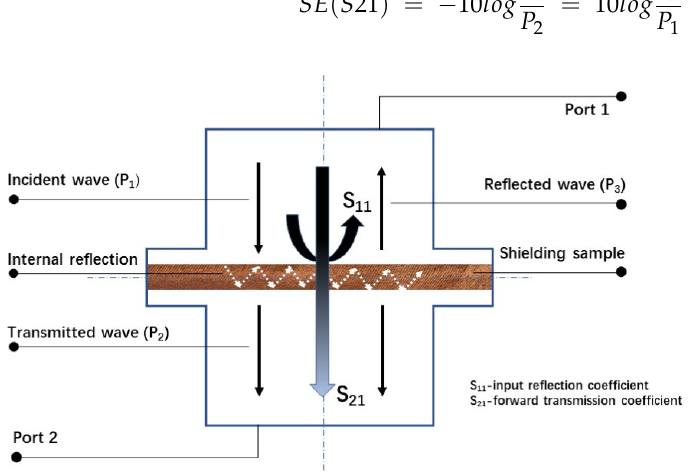
Figure 2. Measurement of SE for MEFTEX.